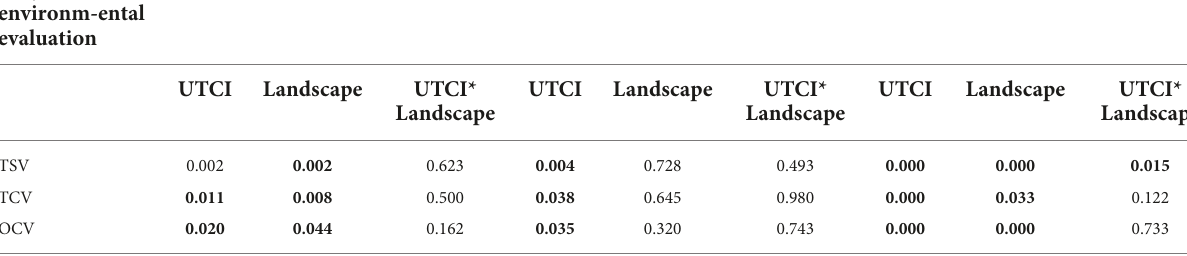
TABLE 4 Significance analysis of the effects of universal thermal climate index (UTCI) and landscape scenes on subjective environmental evaluations. Subjective environm-ental